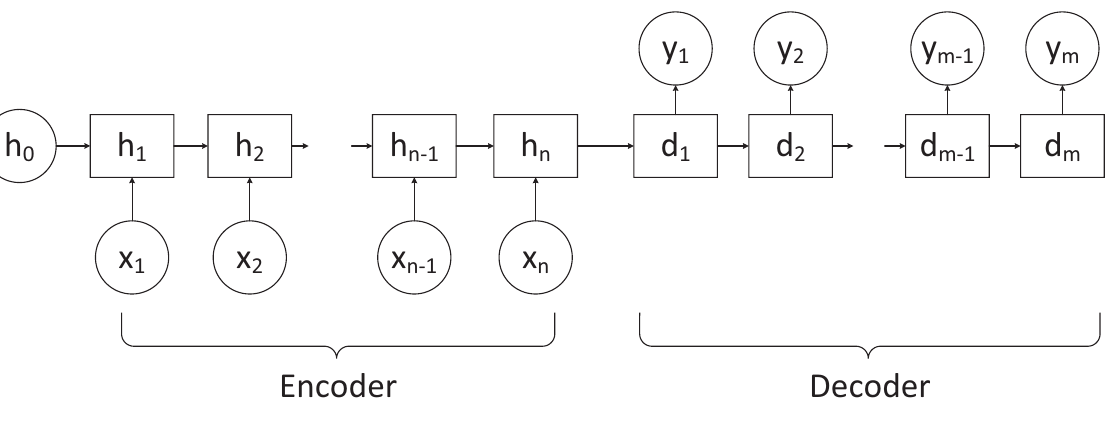
Figure 1. Seq2seq